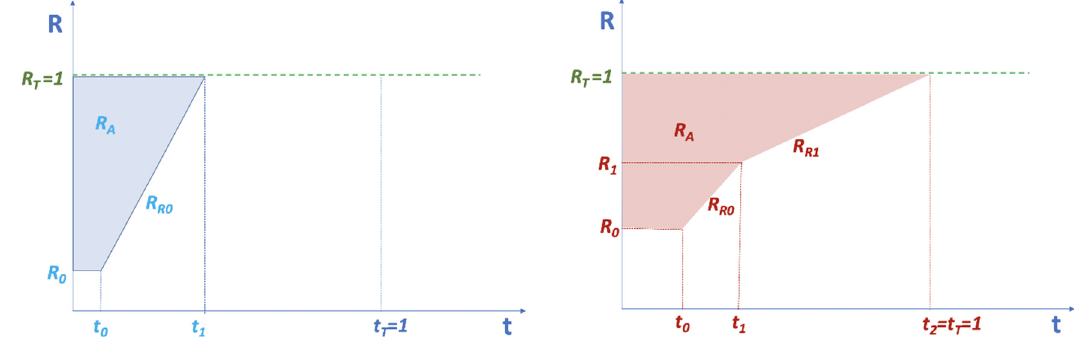
Figure 5. Examples of time–resilience, t-R, plots showcasing the use of the proposed resilience metrics R O , R Ri , and R A.